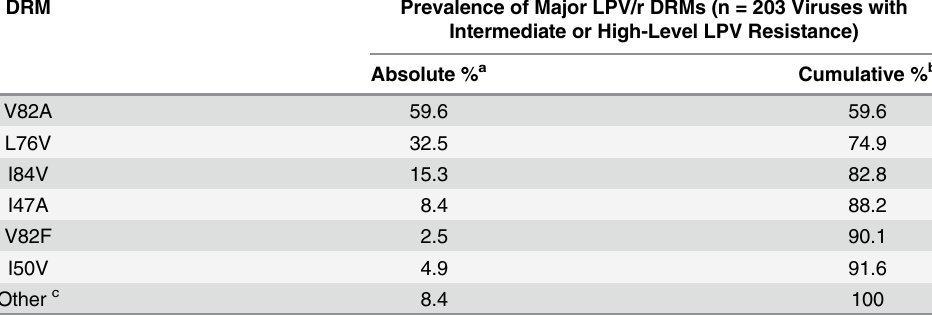
Table 1. Absolute and Cumulative Prevalence of Major Lopinavir-Associated Mutations in 203 Viruses with Intermediate or High-Level Lopinavir (LPV) Resistance from 1,214 Previously PI-Na ï ve